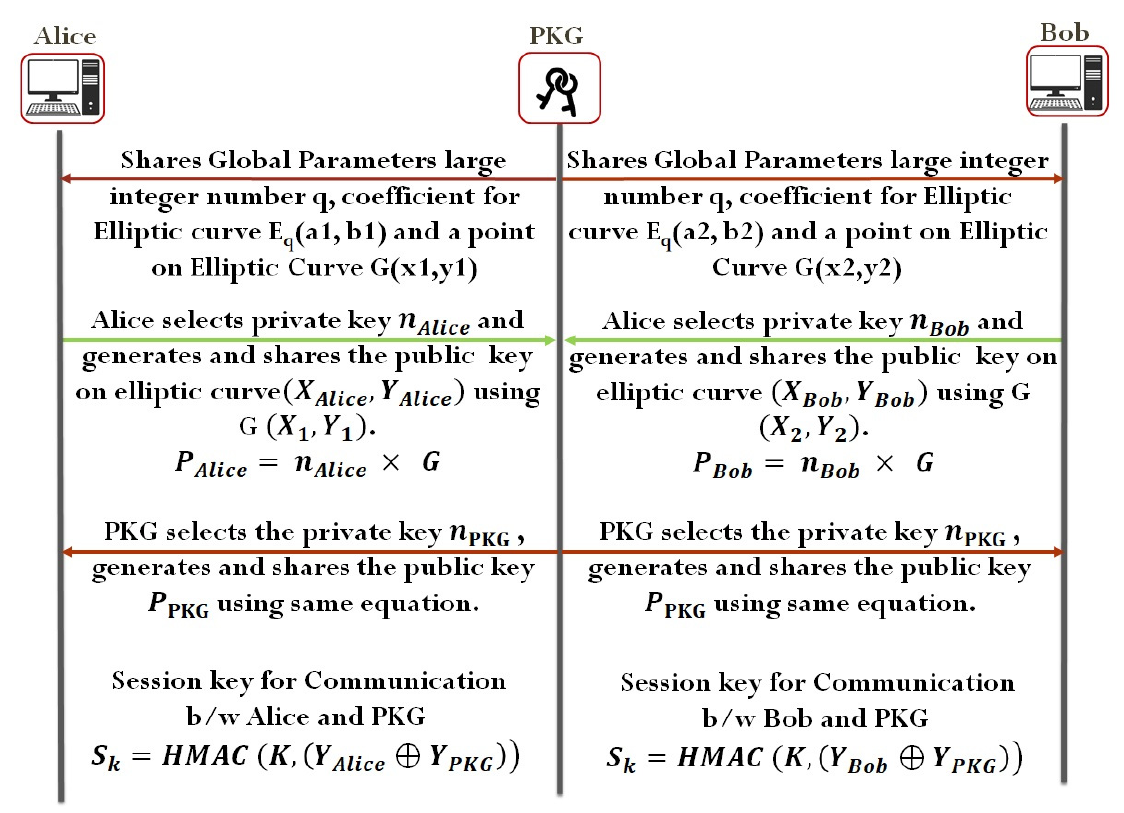
Figure 10. Key exchange scenario between Alice–PKG and Bob–PKG.